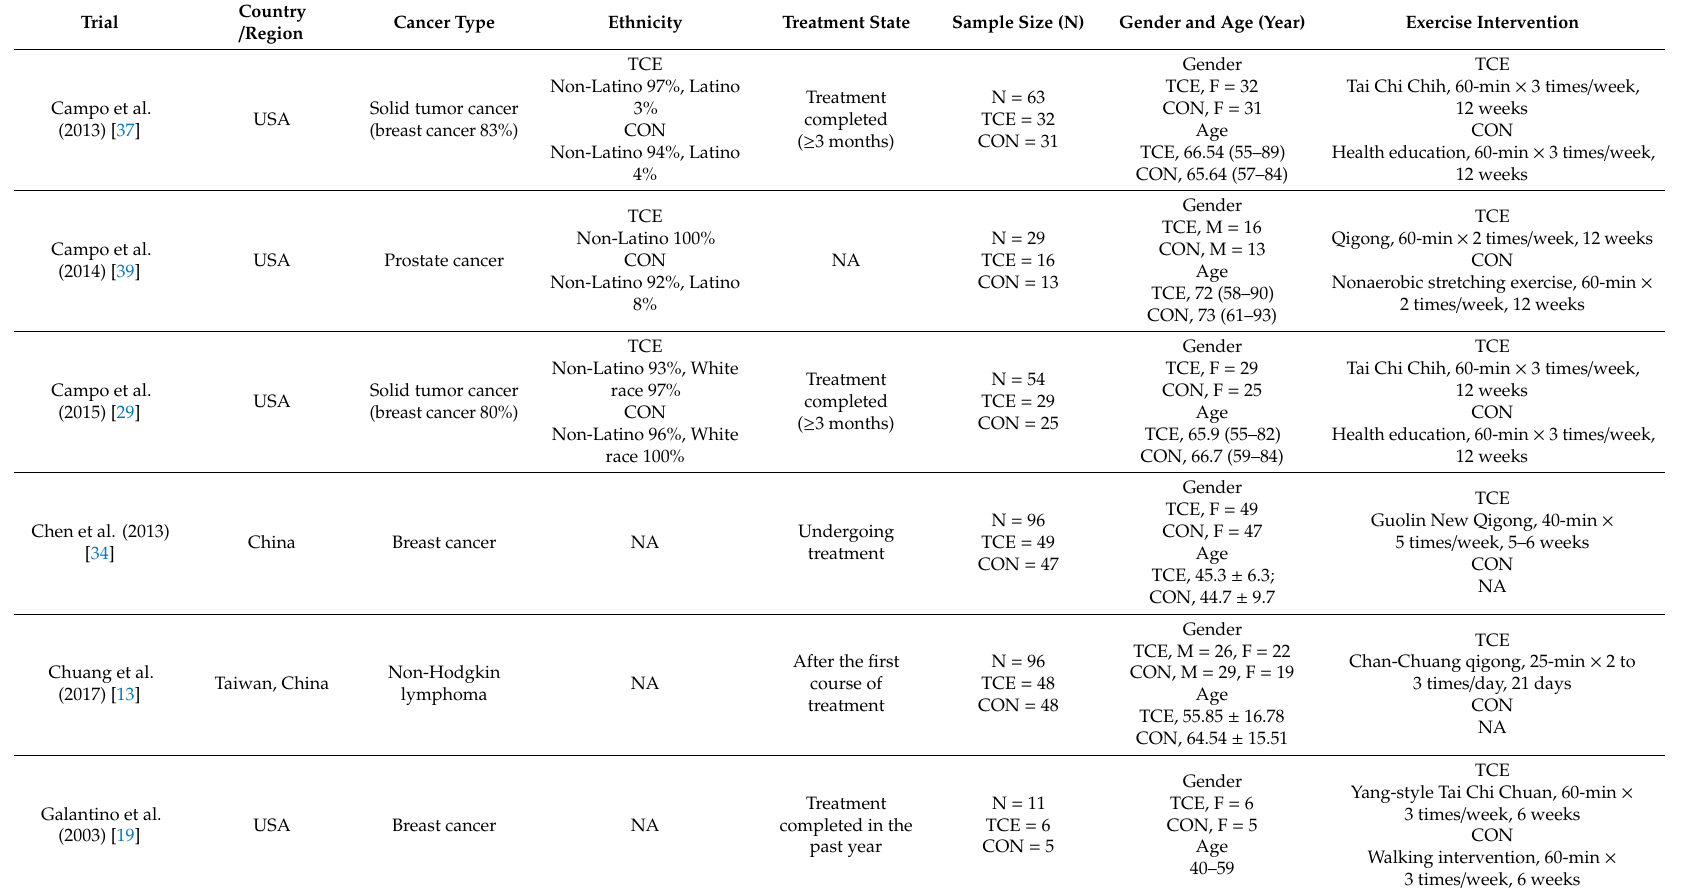
Table 2. The study characteristics of included